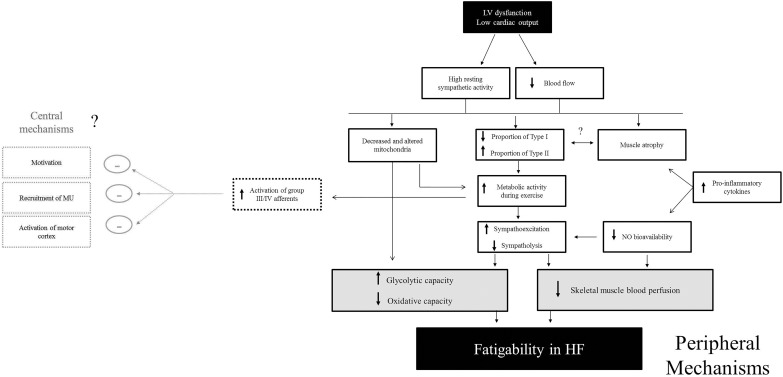
Proposed mechanisms of fatigability in HF patients. Mechanisms contributing to muscle fatigability in HF are likely a cascade of events that may be initiated by high sympathetic activity and reduced cardiac output. This review indicates that peripheral factors likely play a large role in fatigability. In particular, skeletal muscle perfusion and altered muscle metabolism appear to be observed as major contributing factors (shown in gray). Although central factors have not yet been shown to contribute to fatigability in HF, more research needs to be conducted to directly measure neural mechanisms of fatigability in these patients. Because greater activation of skeletal muscle (group III/IV) afferents are known to inhibit motor activity (Garland and Kaufman, 1995), the possibility of greater inhibition of the central nervous system by exaggerated activity of group III/IV afferent (outlined in gray boxes) exists.